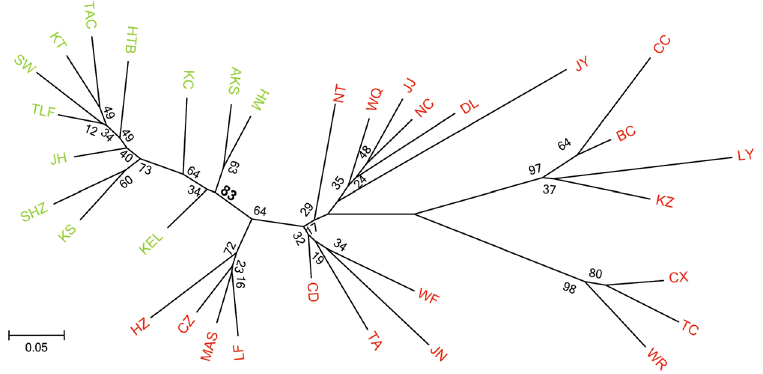
Figure 3. Unrooted NJ tree based on SSR data from 33 Aphis gossypii populations collected in China. Numbers beside the nodes are bootstrap values. Populations from Xinjiang Province, Northwest China with relatively stronger support, are marked as green, and the other populations, from eastern China, are marked as